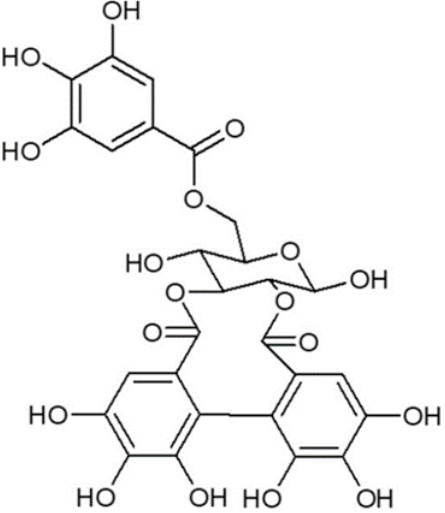
Figure 6. Chemical structure of Galloyl-Hexahydroxidifenoil-Glucose (G-HHDP-G), isolated from the ethyl acetate fraction of the P. granatum crude extract.